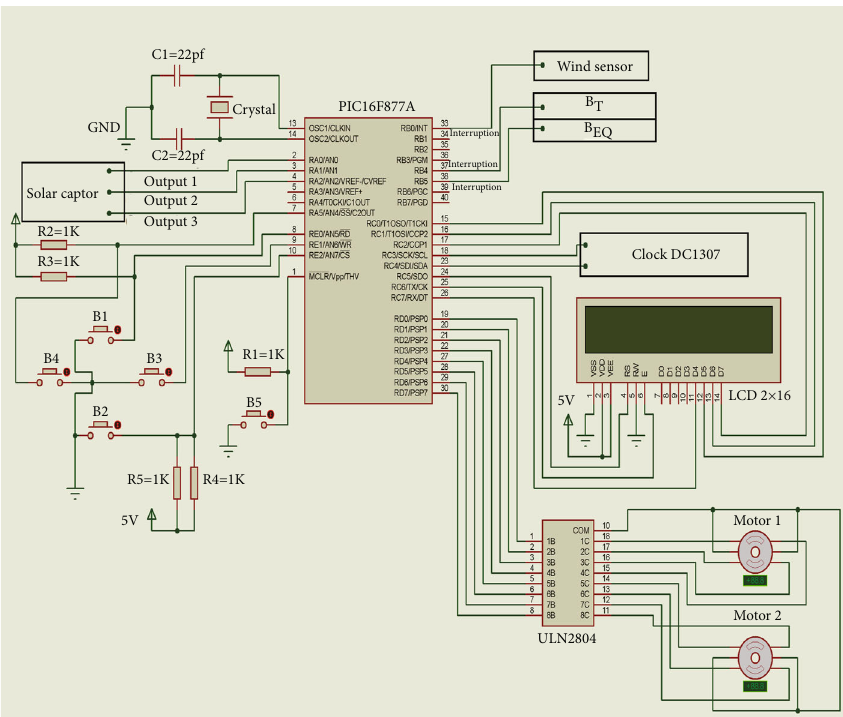
Figure 43: Diagram of the control